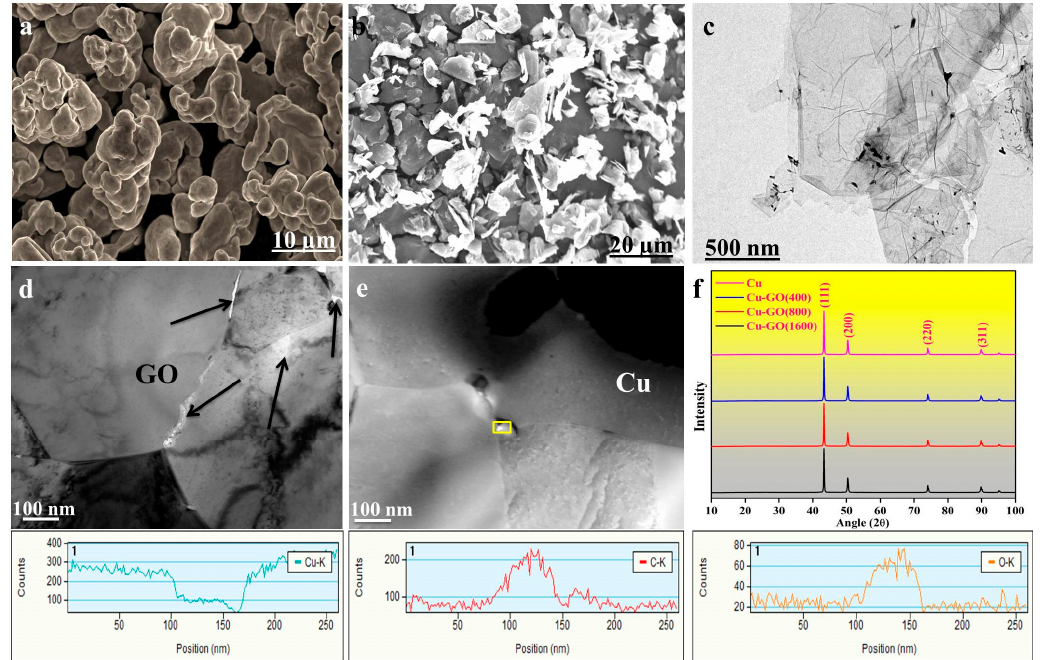
Figure 1. SEM of ( a ) Cu and ( b ) GF, ( c ) TEM of GO and ( d ) Cu-GO (1600 µm), ( e ) TEM with point analysis, and ( f ) XRD of Cu and Cu-GO composites.